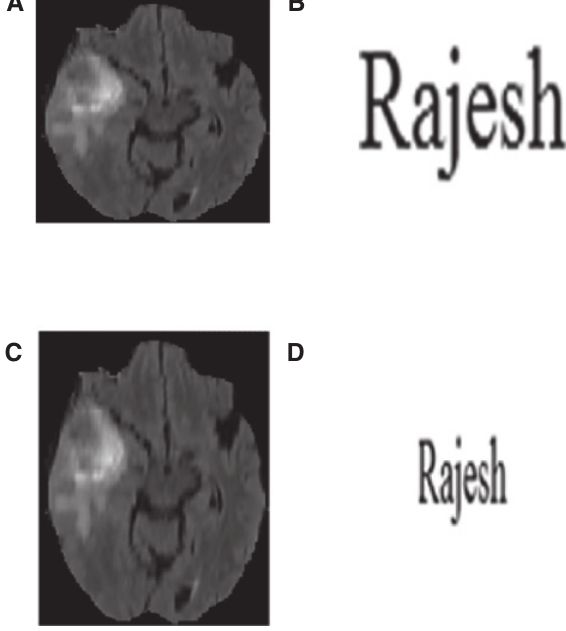
Figure 4: Intermediate Results of Image 2.